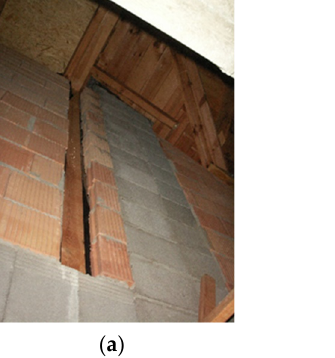
Figure 3. Non-thermally insulated flue pipes: ( a ) in the part above the roof, ( b ) in the attic space. In Europe, modern chimney systems are still being integrated into the existing walls of buildings, thus compromising their spatial rigidity. According to the manufacturers’ claims, chimney risers should be independent and self-supporting structures, but in real- ity they are subjected to additional loads by being “glued” tightly into existing structures (Figure 4).